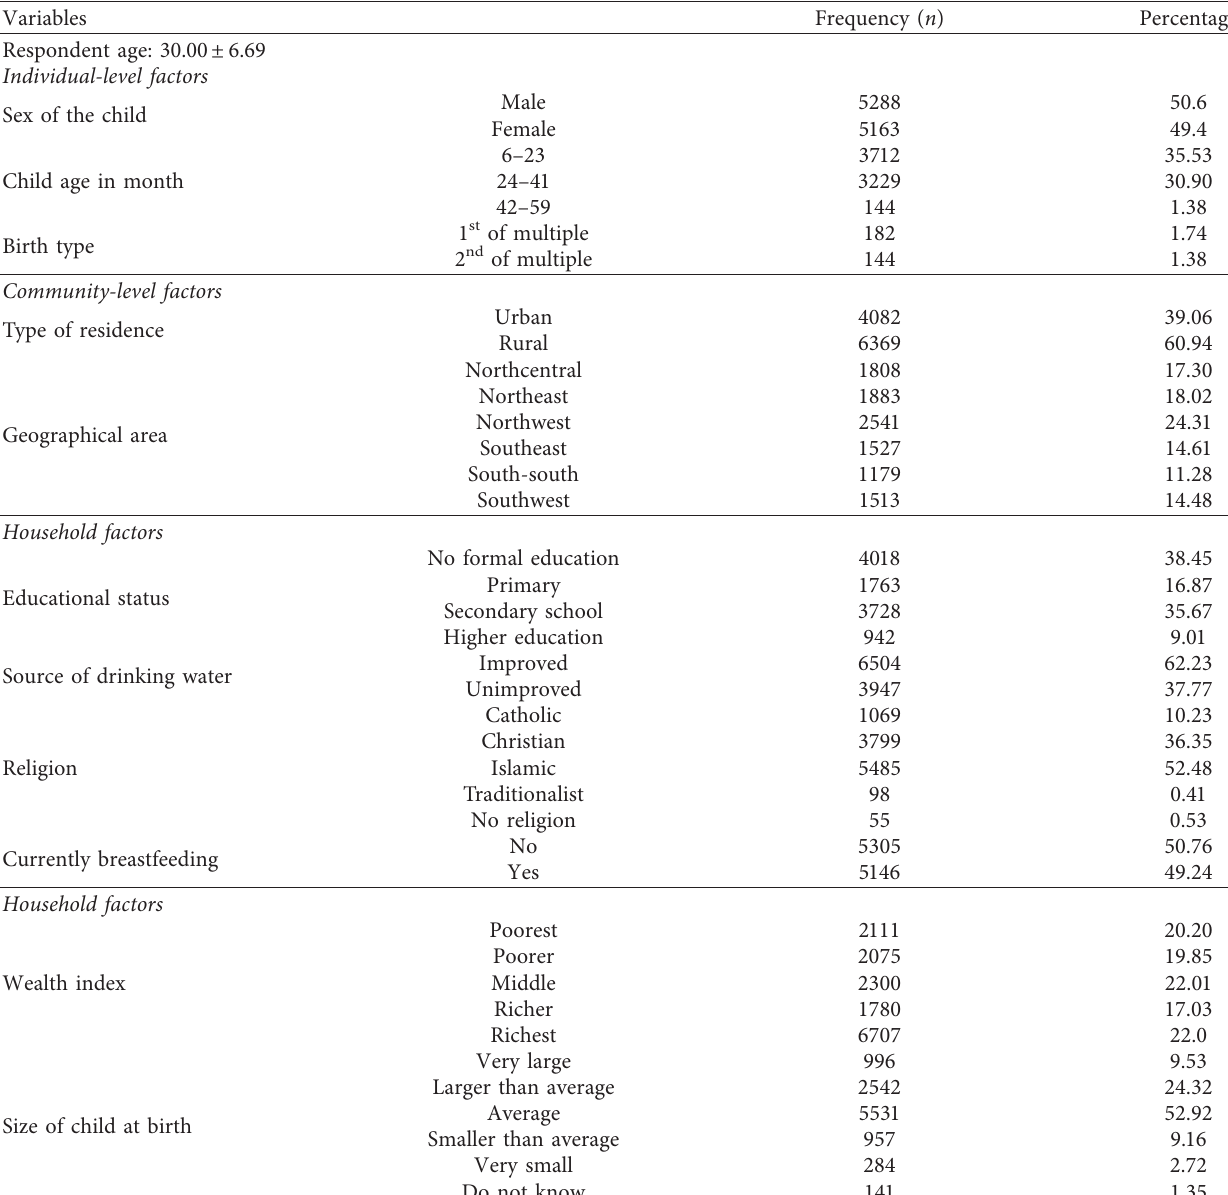
Table 1: Individual-level, community-level, and household-related characteristics of the study participants ( n � 10,451).